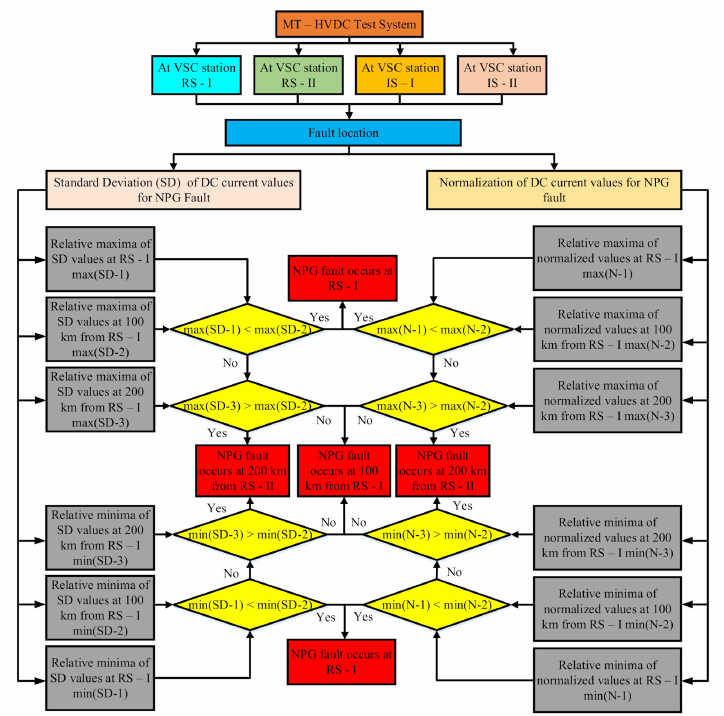
Figure 7. An algorithm for NPG fault location finding based on SVM, using supported features of standard deviation and normalization of DC